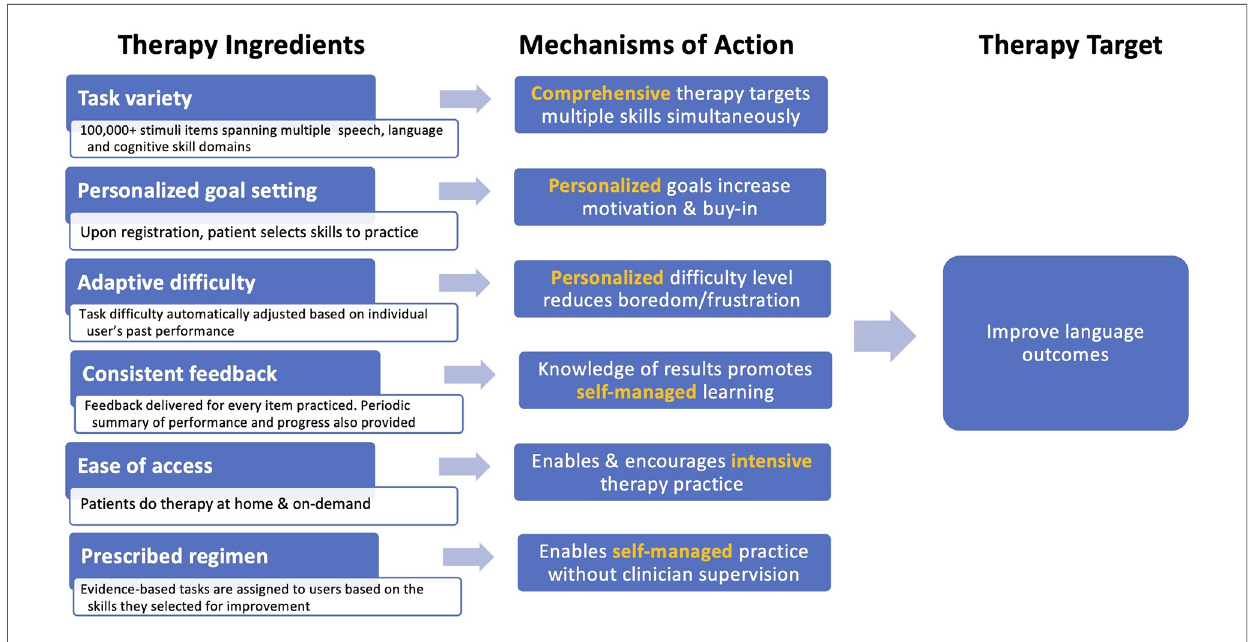
FIGURE 2 Ingredients, mechanisms, and targets of the constant therapy program, conceptualized within the rehabilitation treatment speci fi cation system (RTSS)